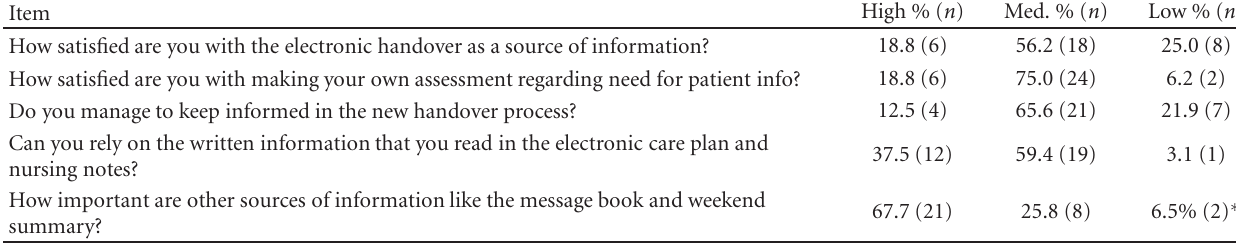
Table 1: The electronic handover.